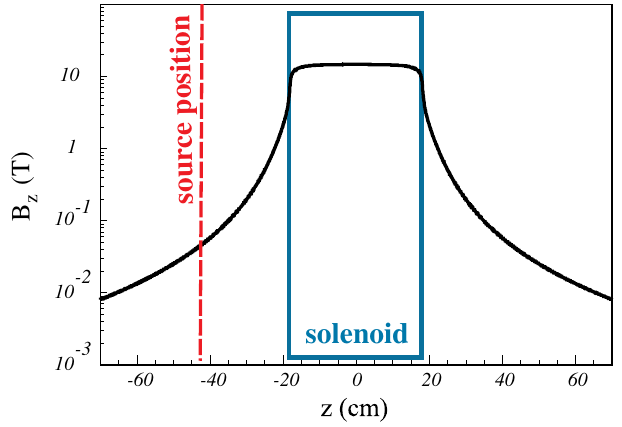
FIG. 6. Calculated values of B z through solenoid versus